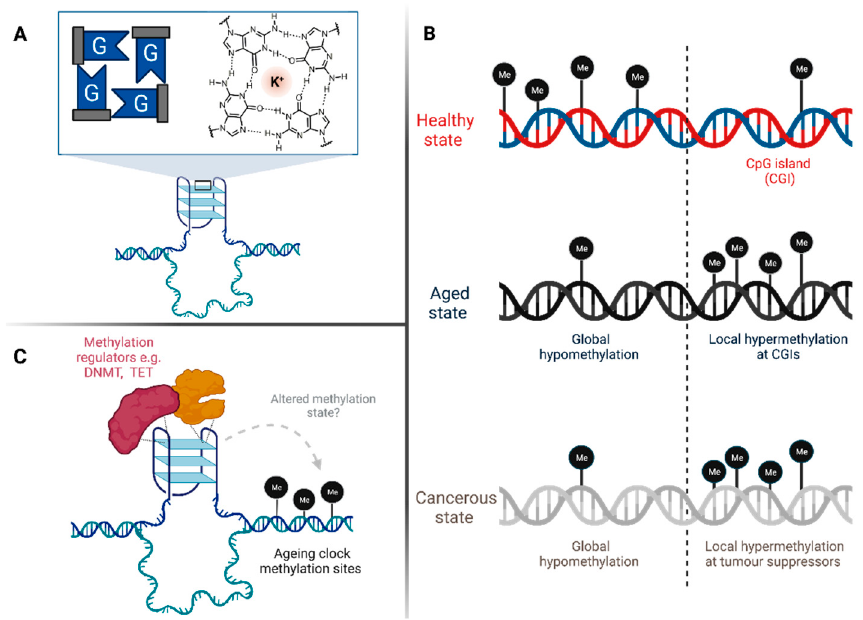
Figure 1. ( A ) Structure of a G4 composed of stacks of guanine quartets. ( B ) Molecular parallels between the methylation changes of aged and cancer cells. ( C ) Model of G4 structures perturbing methylation at ageing clocks sites via interactions with methylation